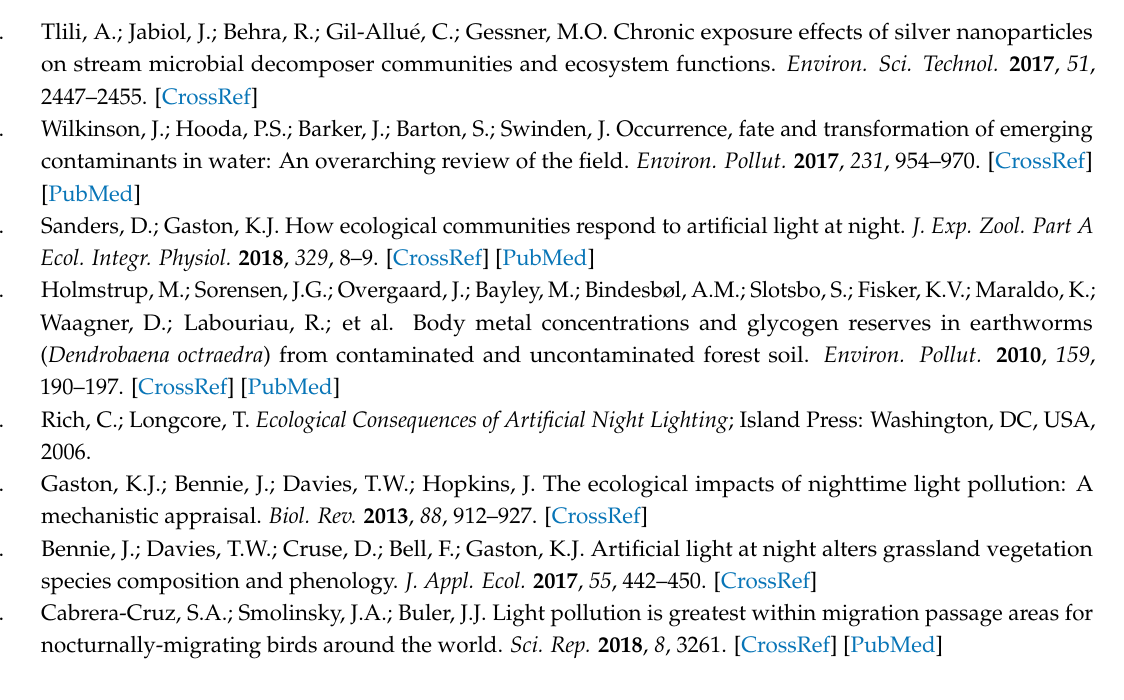
Figure A1. Principal component analysis of the correlation patterns of enzymatic activities and litter decomposition rates (k) in different treatments: ( a ) Natural light simulation group without Pb (N); ( b ) ALAN simulation group without Pb (A); ( c ) natural light simulation group with Pb (N-Pb); and ( d ) ALAN simulation group with Pb (A-Pb). Legends: AP, acid phosphatase; LAP, leucine-aminopeptidase; β -G, β -glucosidase; CBH, cellobiohydrolase; PPO, polyphenol oxidase; PER, phenol oxidase.